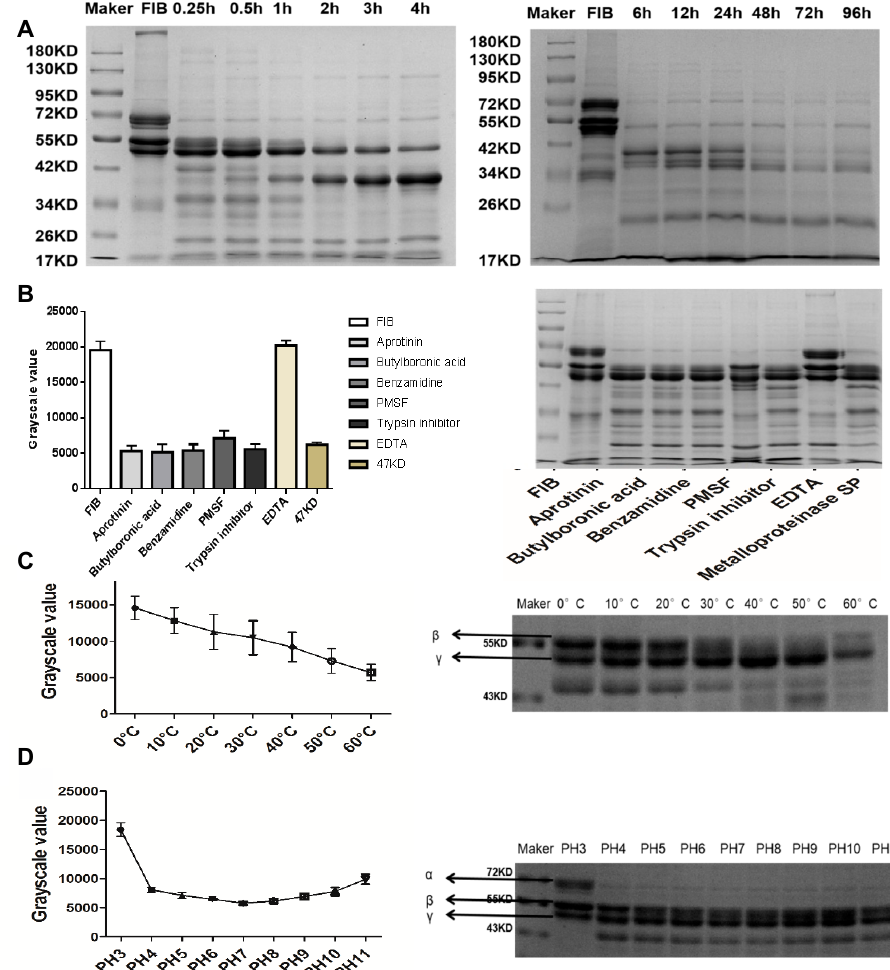
Figure 6. ( A ) Time-dependent effect of metalloproteinase SP on fibrinogen. Fibrinogenolytic activity was evaluated on 12% SDS-PAGE after incubation of metalloproteinase SP (5 μ g) with human fibrinogen at 37 °C for different time periods. ( B ) Effects of inhibitors on metalloproteinase SP. Metalloproteinase SP was pre-incubated at 37 °C for 30 min at the presence of benzamidine (5 mM), ethylenediaminetetraacetic acid (EDTA, 5 mM), butyl boronic acid (20 mM), Trasylol (400 IU), trypsin inhibitor (20 mM), and PMSF (5 mM), respectively, prior to the addition of fibrinogen. ( C ) Temperature dependent effect of metalloproteinase SP on fibrinogen. Effect of temperature on fibrinogenolytic activity was evaluated on 12% SDS-PAGE after incubation of metalloproteinase SP (5 μ g) with human fibrinogen at different temperature for 30 min. ( D ) The pH-dependent effect of metalloproteinase SP on fibrinogen. Effect of pH on fibrinogenolytic activity was evaluated on 12% SDS-PAGE after incubation of metalloproteinase SP (5 μ g) with human fibrinogen at different pH for 30 min. All data were expressed as mean ± SD.